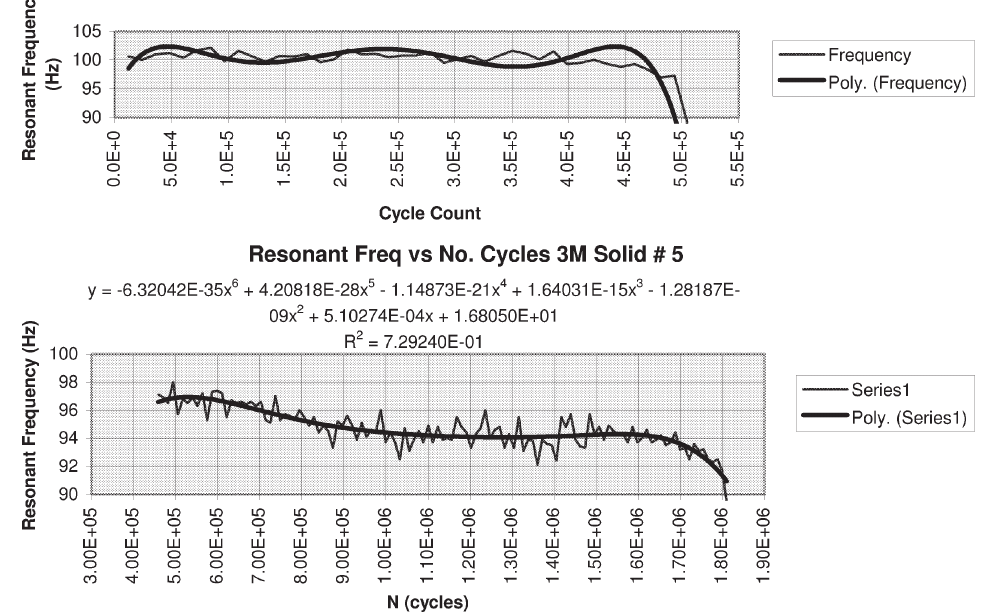
Fig. 8. Example of data smoothing with 6th order